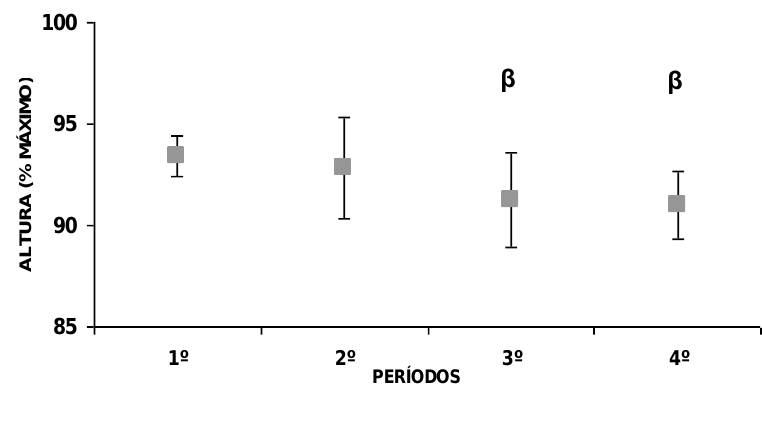
Figura 2- Desempenho normalizado da altura média de salto vertical de cada período durante o protocolo de resistência de saltos verticais. β diferença significativa em relação ao 1° e 2° períodos ( P < 0,05).